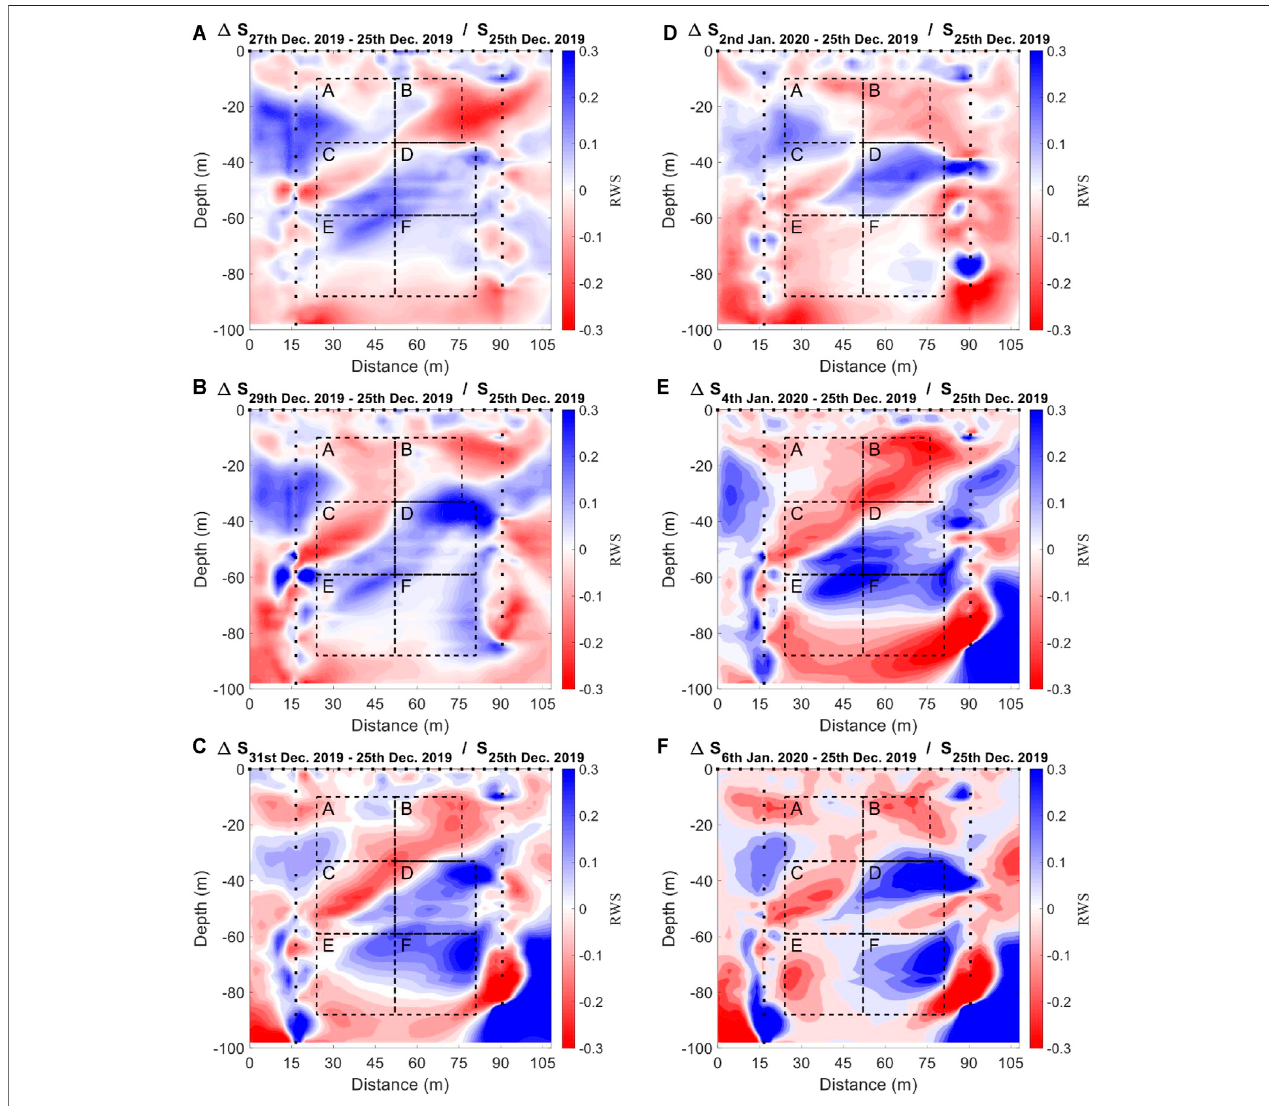
FIGURE 11 | Cross-section of RWS for the short-duration precipitation event (Event n ) based on the map for 04:00 on December 25, 2019, after (A) 2 days, (B) 4 days, (C) 6 days, (D) 8 days, (E) 10 days, and (F) 12 days. Blue shows increasing RWS, whereas red shows decreasing RWS.